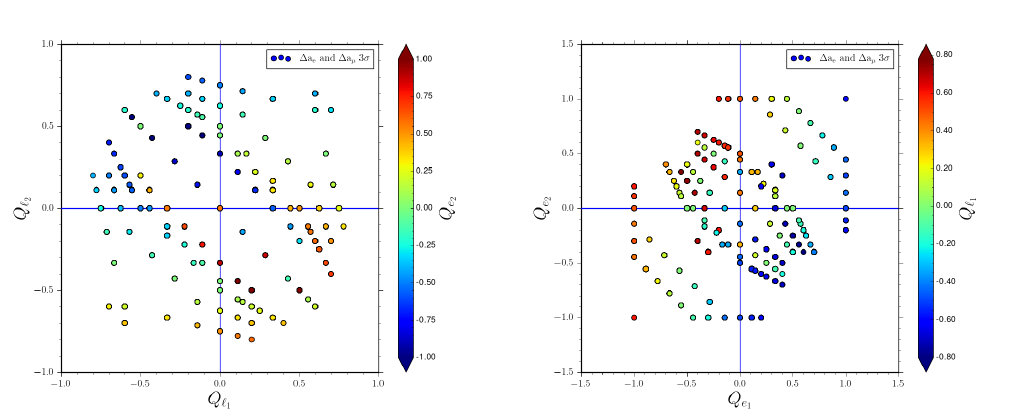
and Q (on left) and Q L 2 1